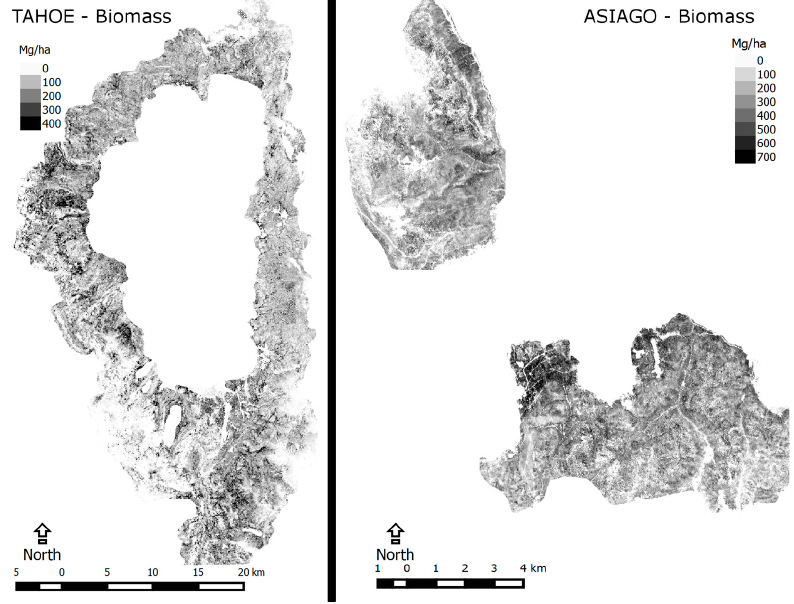
Figure 2. Lidar-derived AGB map for Tahoe area ( left ) and Asiago area ( right ).